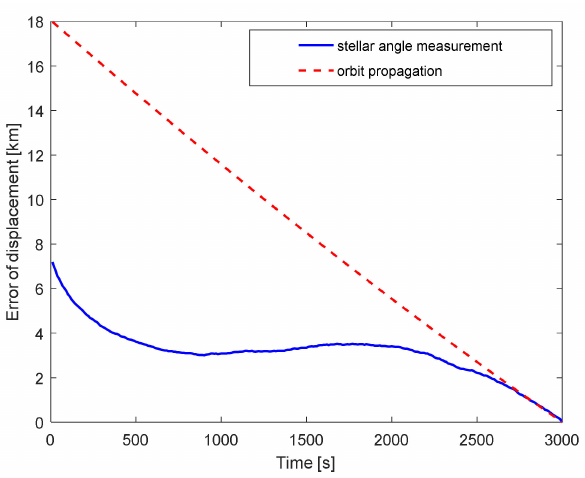
Figure 6. Displacement of spacecraft 3.